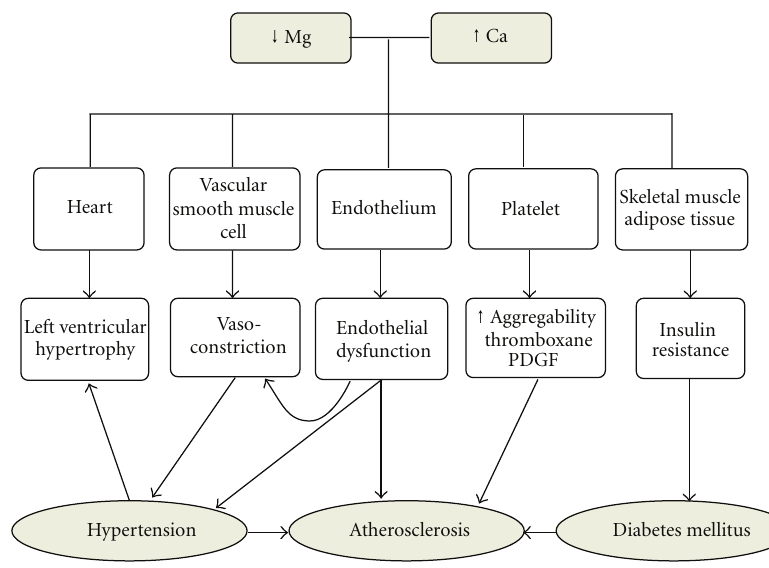
Figure 1: Role of magnesium and calcium in the pathophysiology of hypertension, diabetes mellitus, and atherosclerosis.